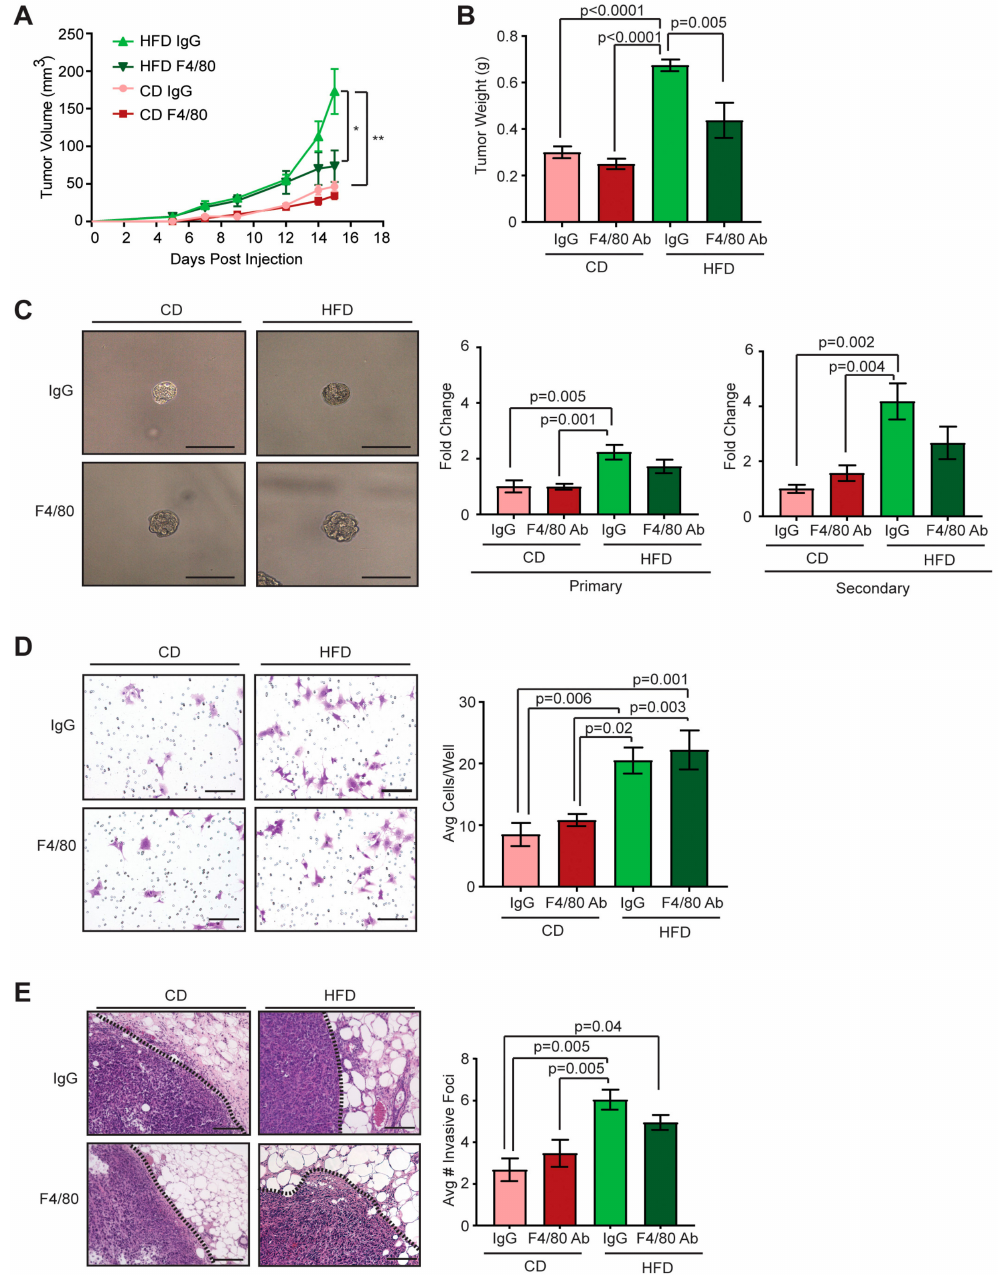
Figure 4. Depletion of macrophages has limited e ff ects on functional CSCs in Met-1 tumors from lean or obese mice. Lean or obese FVB / N female mice were transplanted with Met-1 tumor cells, and received treatment with either anti-F4 / 80 or IgG control antibodies ( n = 3–4 / group). Tumor growth curves ( A ) and end stage tumor masses ( B ) from treated mice. Tumor growth and end stage tumor masses analyzed with two-way ANOVA with Tukey’s multiple comparison test (* p < 0.0001 HFD IgG compared to HFD F4 / 80; ** p < 0.0001 HFD IgG compared to CD IgG and HFD IgG compared to CD F4 / 80). ( C ) Isolated Met-1 tumor cells were plated in limiting dilution on non-adherent plates to form tumorspheres ( n = 3–4 / group). Tumorspheres were dissociated and re-plated to form secondary tumorspheres (two-way ANOVA with Tukey’s multiple comparison test). ( D ) Isolated Met-1 tumor cells were plated on collagen-coated migration chambers, and invading cells were quantified ( n = 3 / group; two-way ANOVA with Tukey’s multiple comparison test). ( E ) Quantification of Met-1 tumor cell invasive foci into surrounding adipose tissue ( n = 3–4 / group; two-way ANOVA with Tukey’s multiple comparison test). Bars represent mean ± s.e.m. Magnification bars = 50 µ